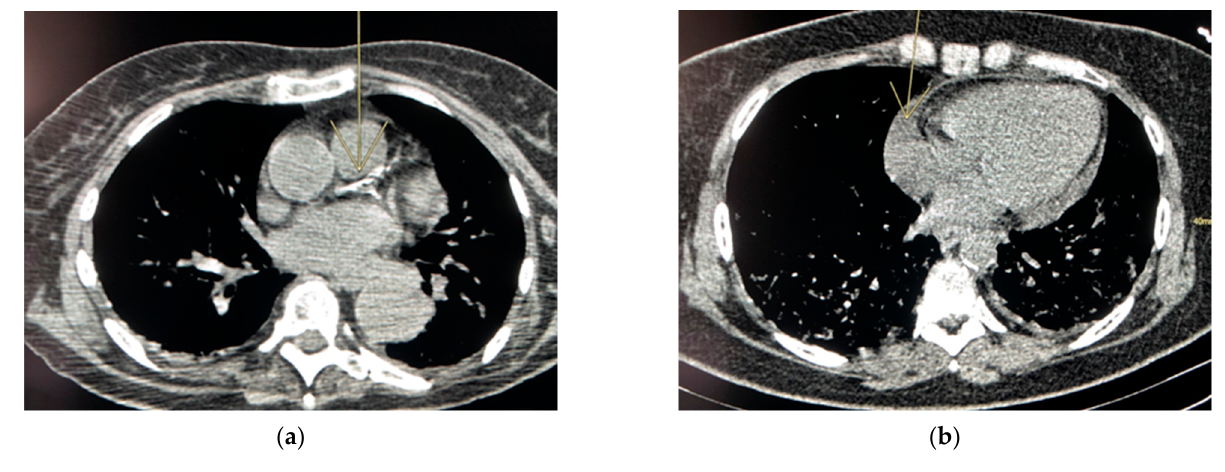
Figure 1. Calcified coronary atherosclerosis and pericardial effusion. ( a ) Chest CT of a 62-year-old woman performed in the context of suspected COVID-19 pneumonia with de novo discovery of calcifying atheromatosis. Coronary calcifications on left coronary artery ((left anterior descending artery and circumflex artery). ( b ) Chest CT of 58-year-old woman performed in the context of suspected COVID-19 pneumonia with novo discovery of a centimetric circumferential pericardial effusion. Interestingly, we found that 8.8% of the patients were suffering from vertebral compres- sion, whereas those lesions were not previously described in 3.3% of the total population. The presence of a nodule on the chest CT scan, regardless of its origin, was found in 26% of the sample. Incidental nodules were then identified in 18.8% of the total cohort (example of chest CT in Figure 2b,c). A newly identified suspicious mass or a suspicious lesion greater than 3 cm was found in 5% (example of chest CT in Figure 2a).